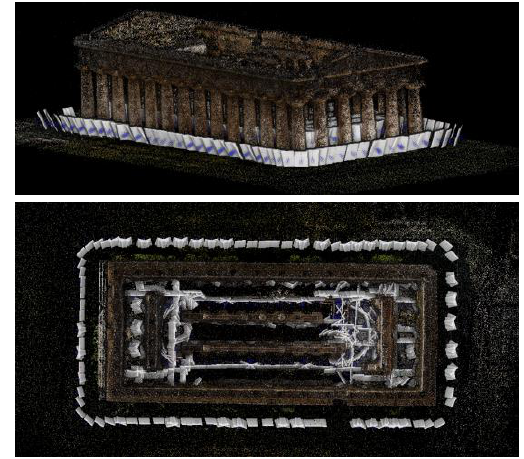
Figure 3: Camera poses and sparse point cloud for the Neptune image